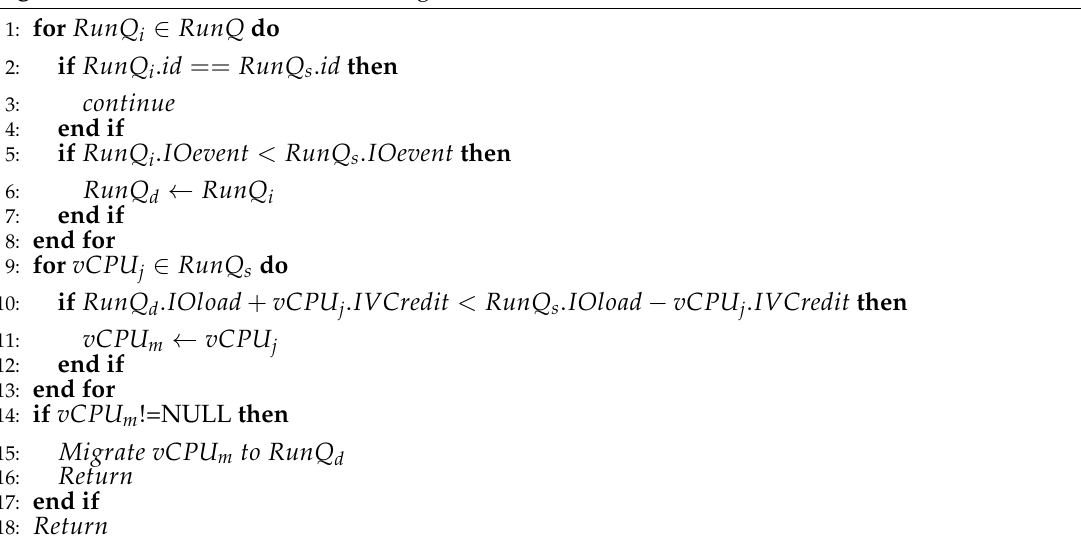
Algorithm 2 ISACS: I/O load-balancing.